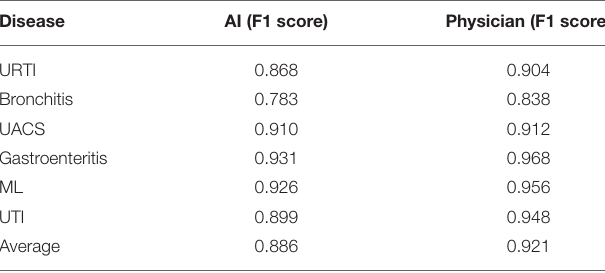
TABLE 3 | Diagnostic performance of the AI model and the physician for the dataset three ( n = 742). Disease